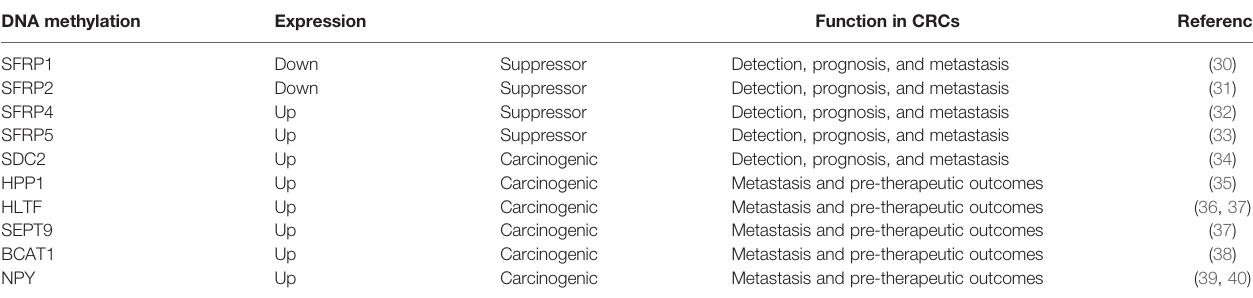
TABLE 1 | Potential DNA methylation seen in colorectal cancers (CRCs). DNA